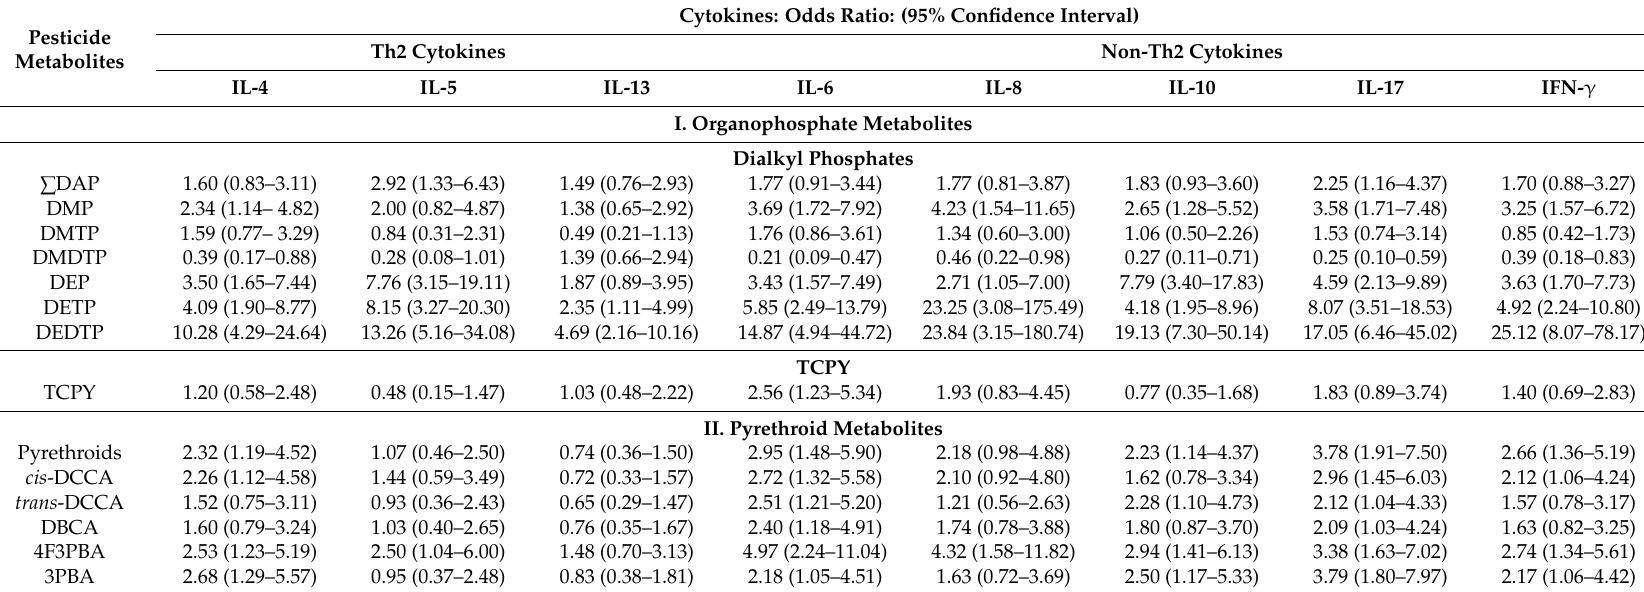
Table 6. Adjusted multiple logistic regression models of the association between pesticide metabolites and individual inflammatory cytokines. Cytokines: Odds Ratio: (95% Confidence Interval) Pesticide Th2 Cytokines Non-Th2 Cytokines Metabolites IL-4 IL-5 IL-13 IL-6 IL-8 IL-10 IL-17 IFN- γ I. Organophosphate